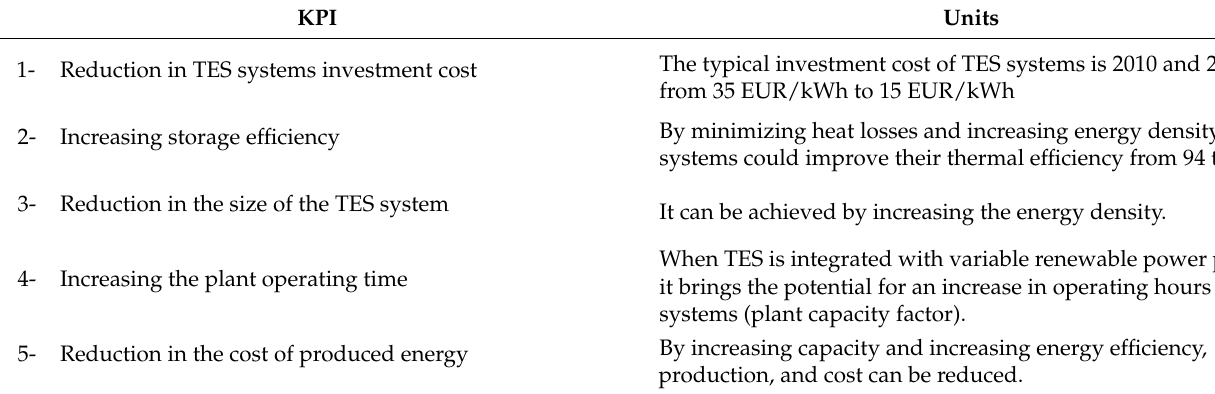
Table 7. Description of the main key performance indicators (KPI) [66].